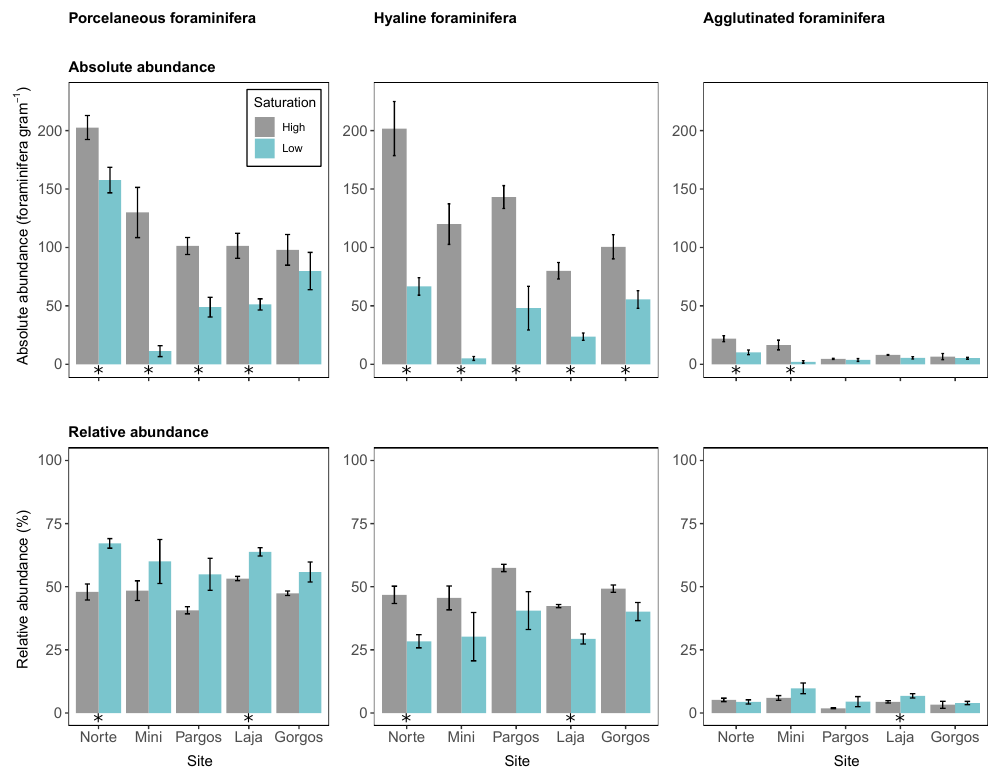
Figure 4. Absolute abundance (specimens per gram of sediment) and relative abundance (percentage) of different foraminifera test types (porcelaneous, hyaline, and agglutinated). Data are represented in mean ± SE ( n = 5). The asterisk demarks a significant difference ( p< 0 . 05) in abundance between paired springs and controls at each site, according to Mann–Whitney rank sum